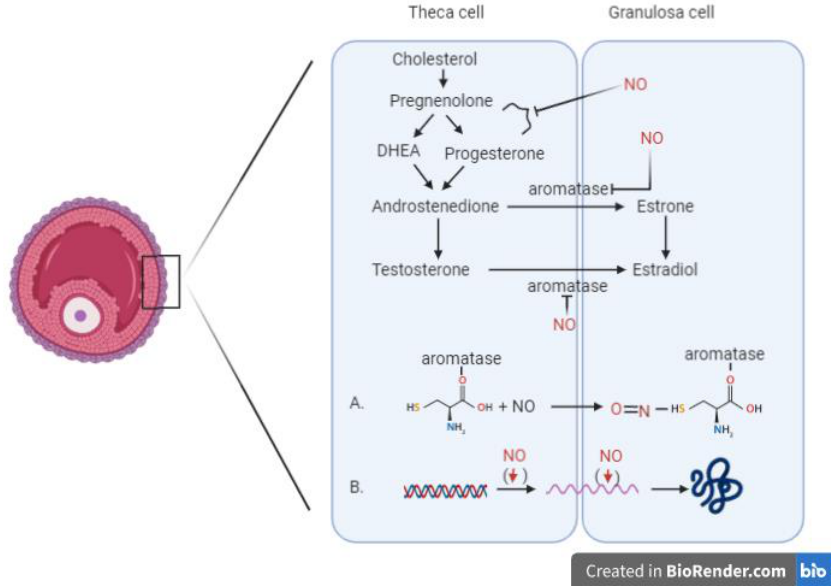
Figure 1. Involvement of nitric oxide in the process of steroidogenesis. Two different mechanisms inhibiting the aromatase enzyme: ( A ) Direct inhibitory effect of NO mediated by the formation of a nitrosothiol group in the cysteine residue of the aromatase enzyme. ( B ) Indirect mechanism resulting in the downregulation of aromatase transcription, with decreasing mRNA values for the enzyme. (DHEA: Dehydroepiandrosterone)